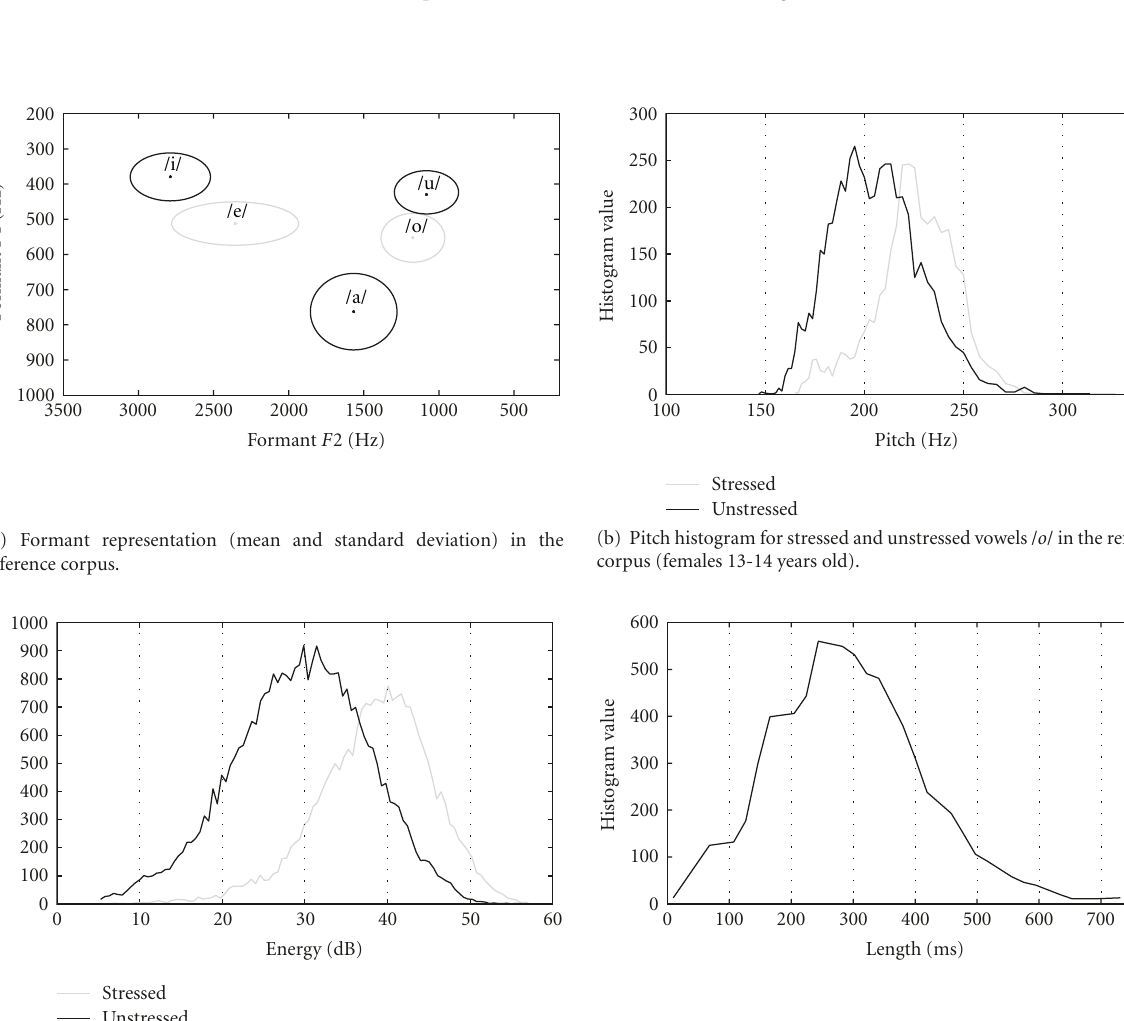
Figure 2: Examples of the outcome of the automated segmentation